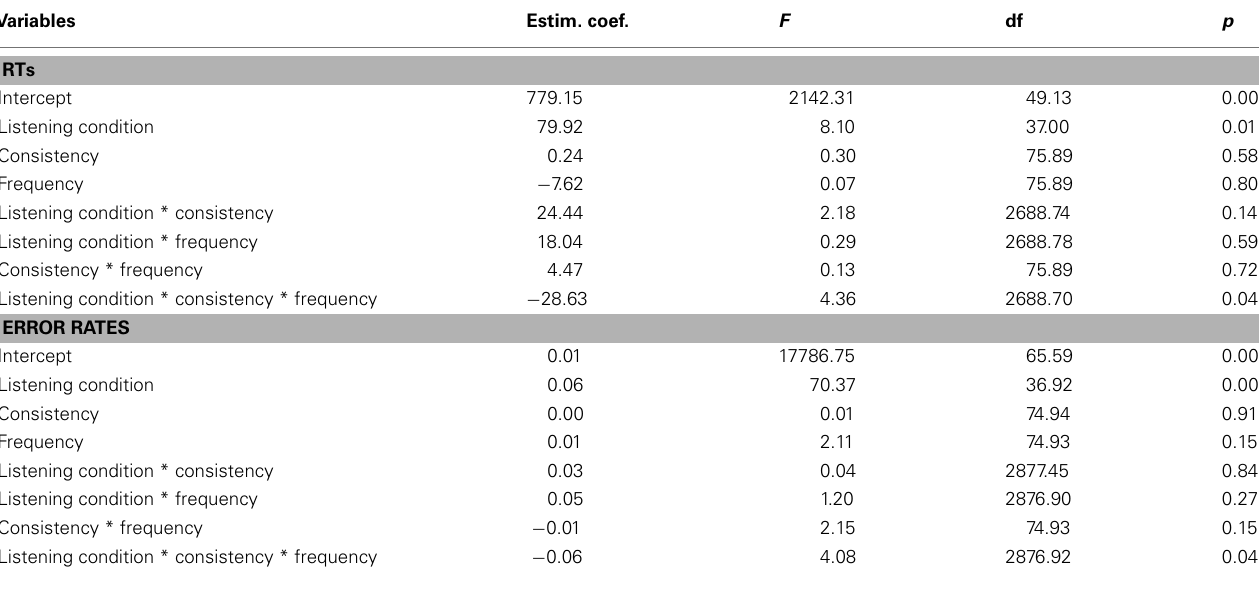
Table 5 | Summary of the mixed-effects model on the RTs and the error rates. Variables Estim.